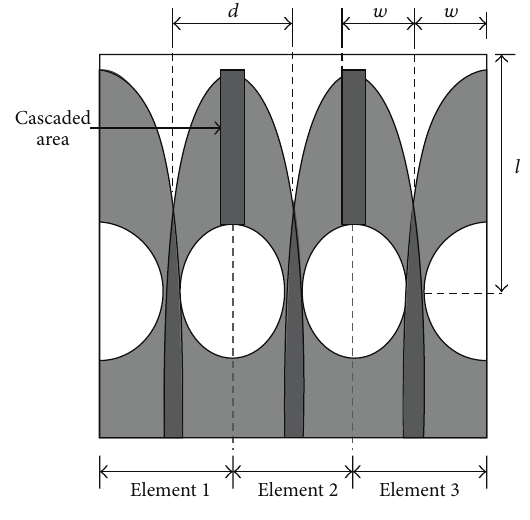
Figure 8: Measured VSWR of the